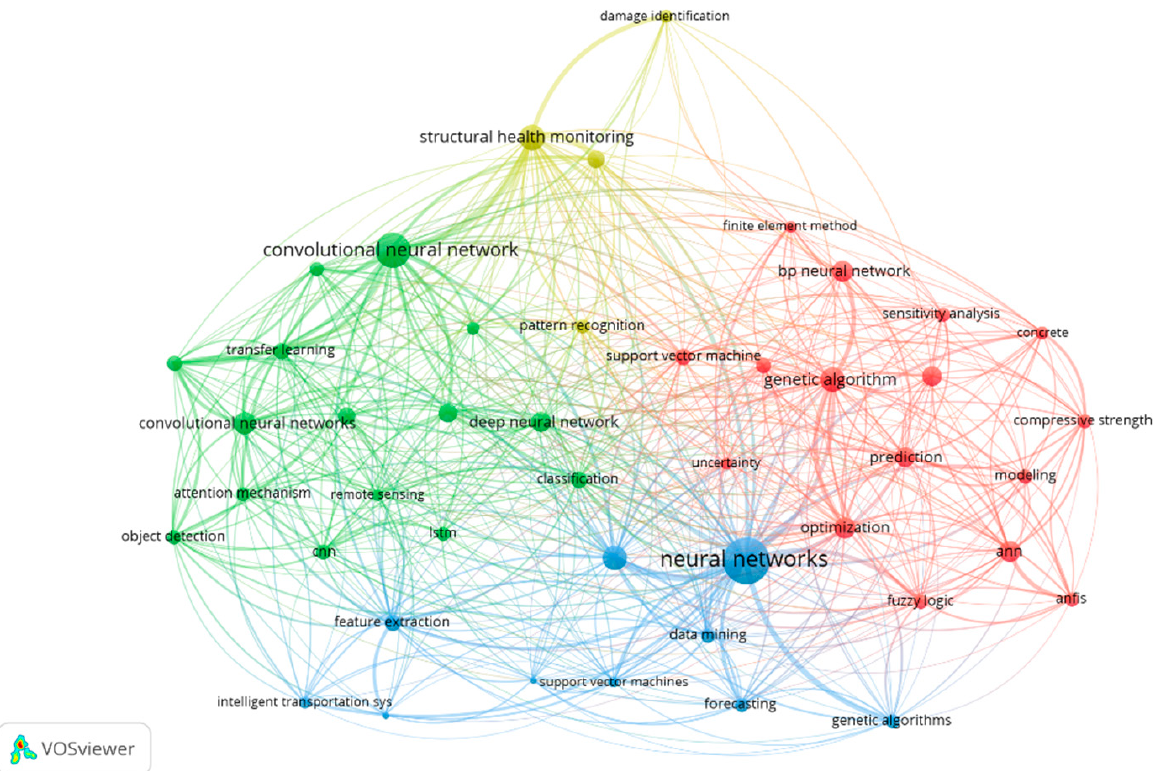
Figure 2. Bibliometric map of the co-occurrence of top-50 keywords of documents including “neural networks” in the “Engineering” field, in Scopus (until 26 December 2022).